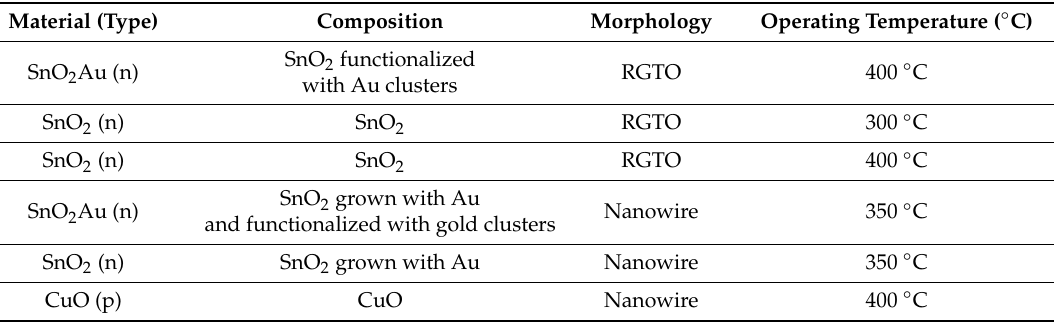
Table 2. Type, composition, morphology, and operating temperature for S3 sensors made at the SENSOR